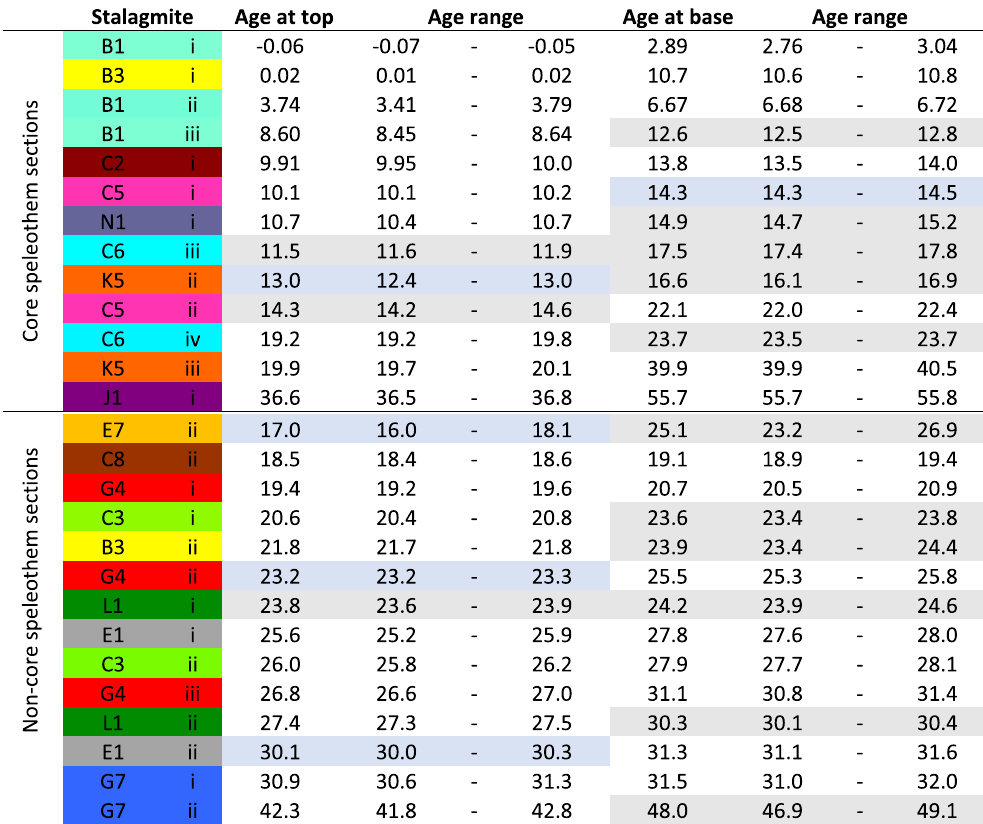
Table 1. Summary of Liang Luar speleothem growth phases and their relationship with millennial-scale events. Grey boxes indicate sections with new growth during millennial-scale ‘wet’ events or stop growing at the end of millennial-scale wet events or the ensuing 500 years. Blue boxes indicate sections that stop growing during millennial-scale ‘wet’ events or start growing at the end of millennial-scale ‘wet’ events or the ensuing 500 years. The best correlation of the ISCAM age model is not centered within the age range and, rarely, can be outside this range (see